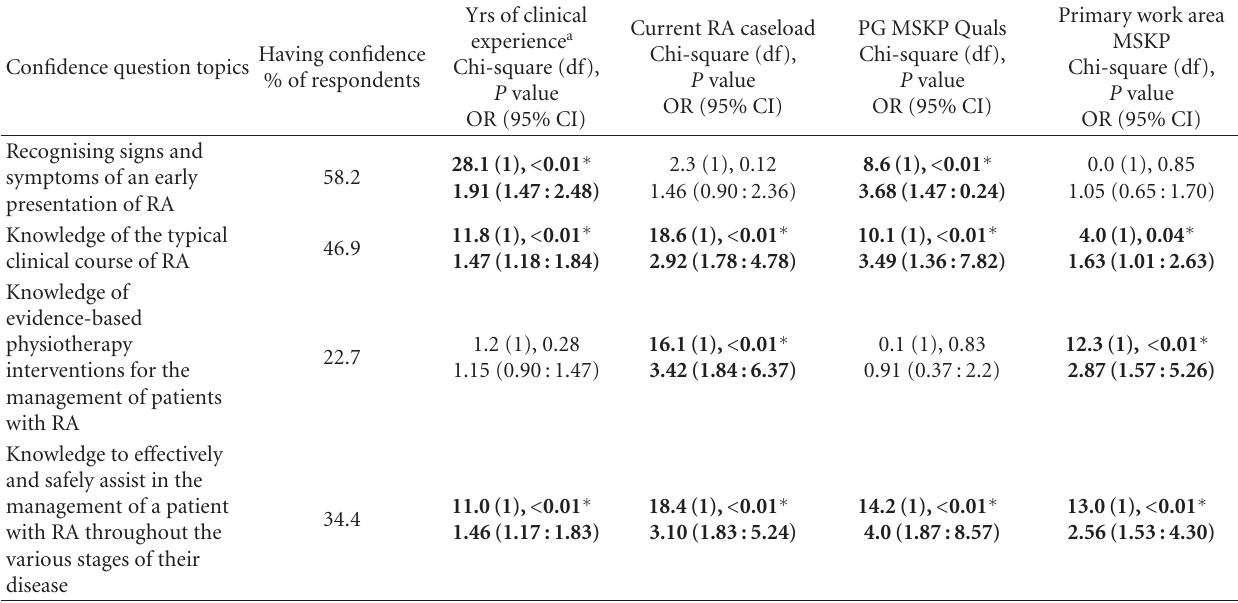
Table 2: Association between having confidence and the variables of years of clinical practice experience, current caseload of consumers with RA, postgraduate (PG) qualifications in musculoskeletal physiotherapy (MSKP), and primary area of work in MSKP ( n =